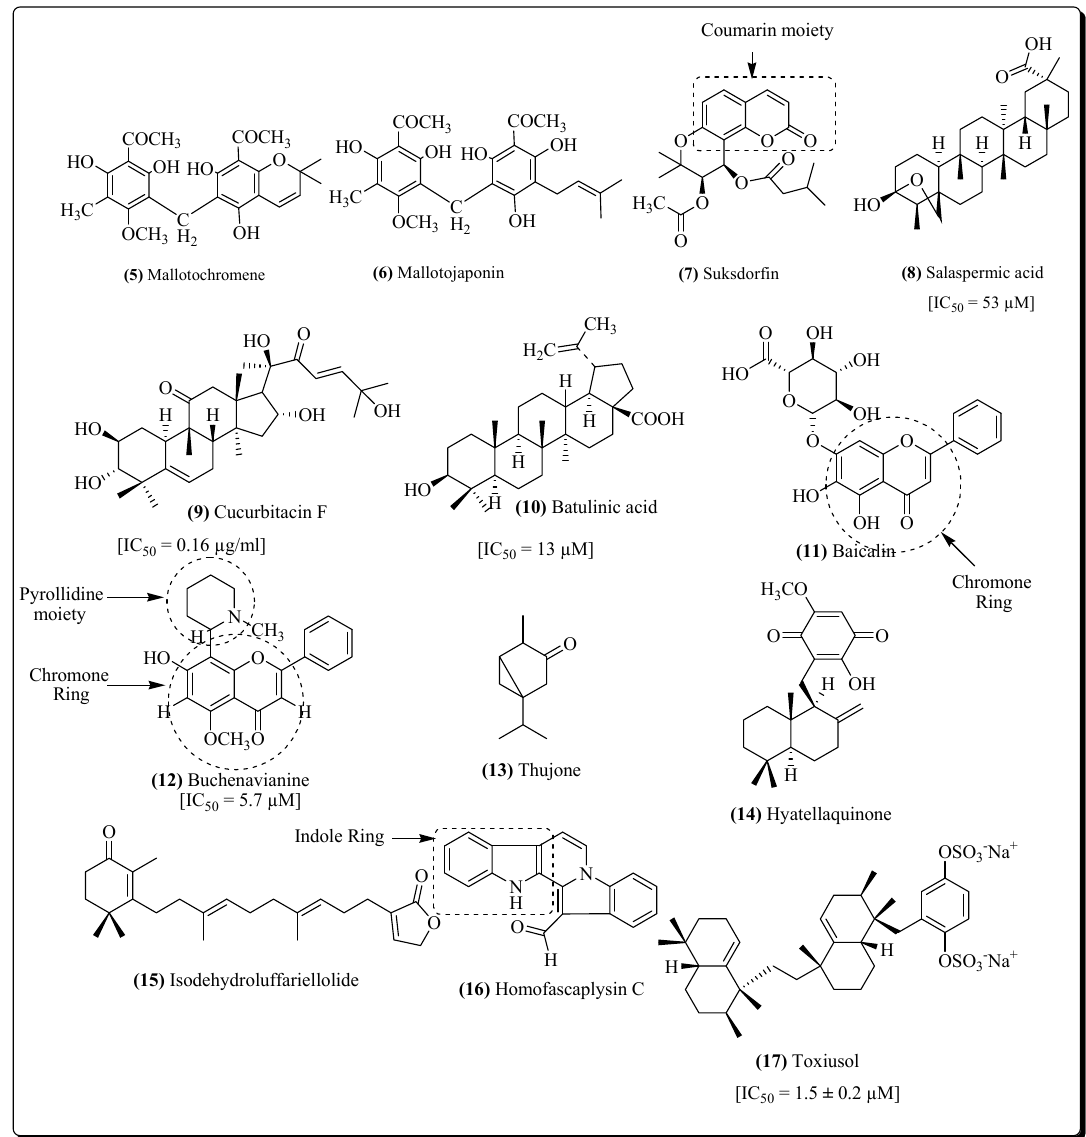
Figure 5. Structure of some potent reverse transcriptase inhibitors.